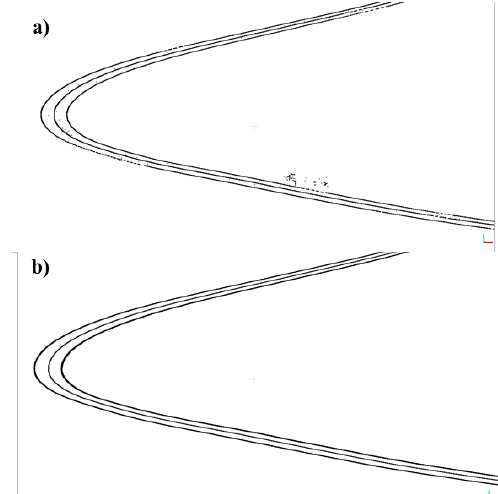
Figure 1. a) points with an intensity higher than 80%, b) points after selection by continuity and scan angle.